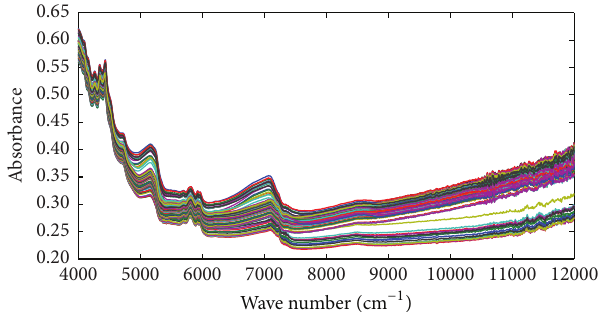
Figure 1: Near infrared spectra of 64 samples of Puccinia striiformis f. sp. tritici